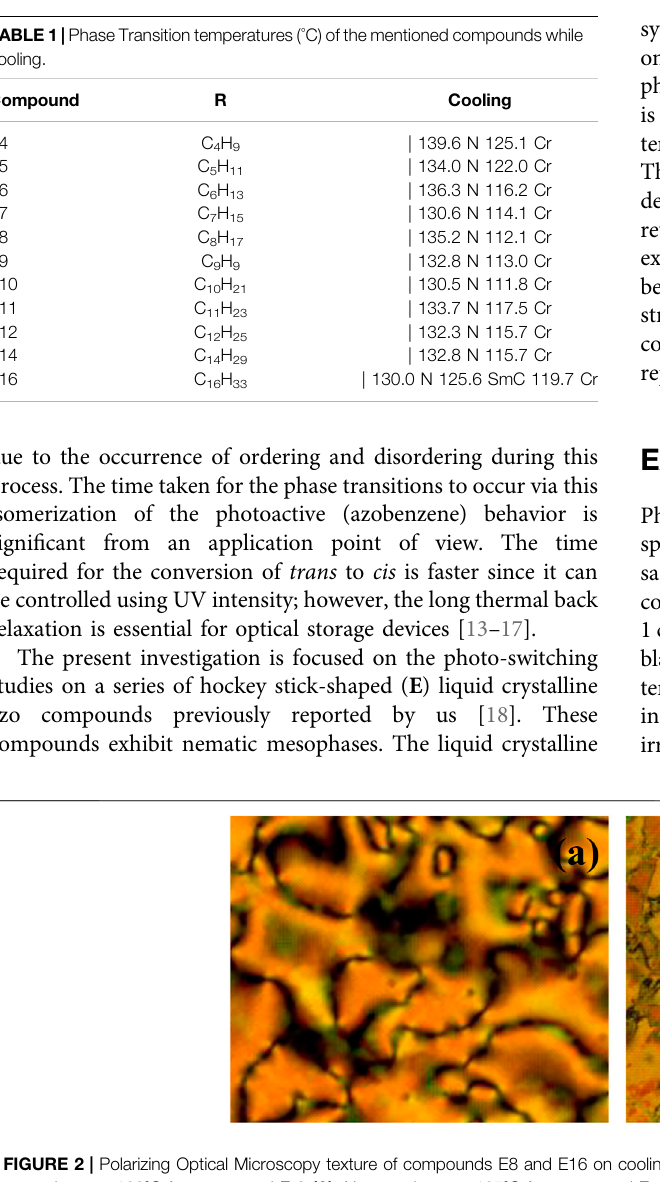
Frontiers in Physics |